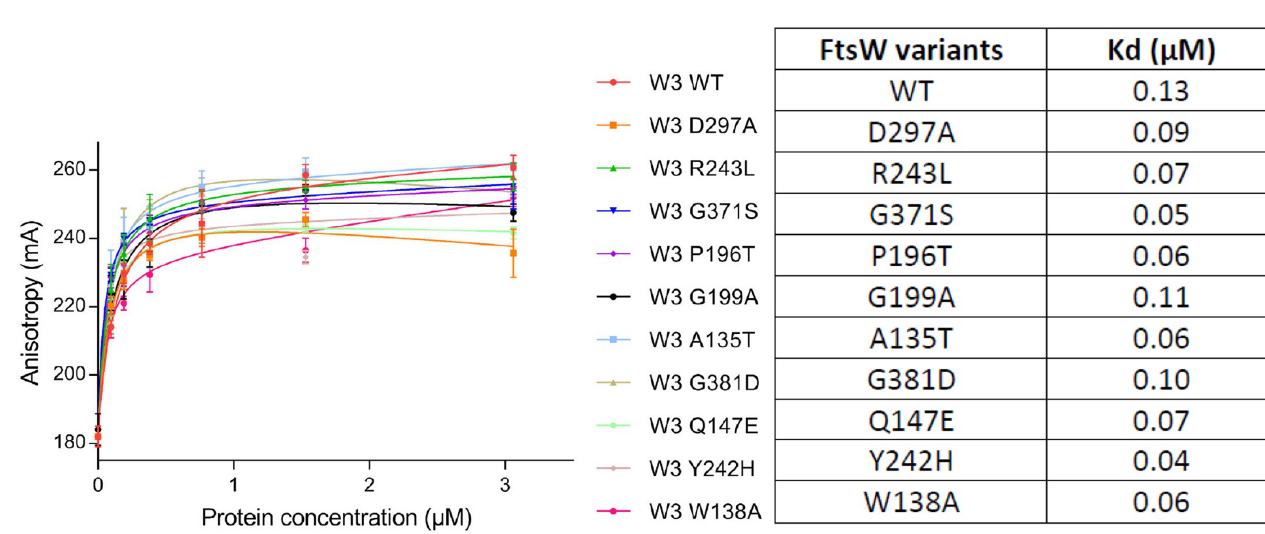
PLOS Genetics | https://doi.org/10.1371/journal.pgen.1009993 January5,